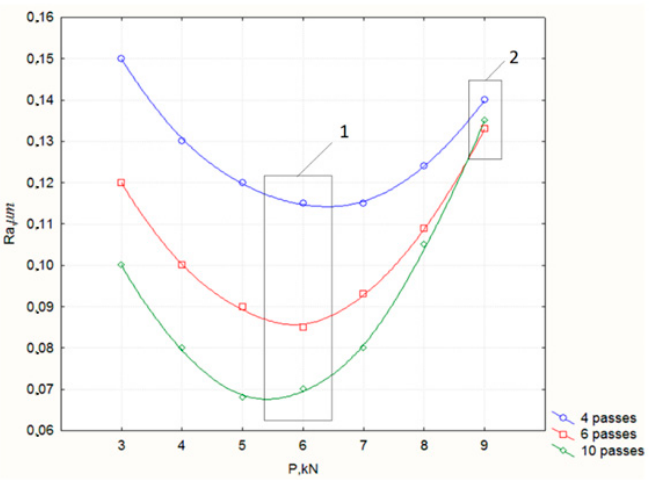
Figure 9. The surface roughness variation depending on the WB indenter pressure for AISI 1040 work piece.